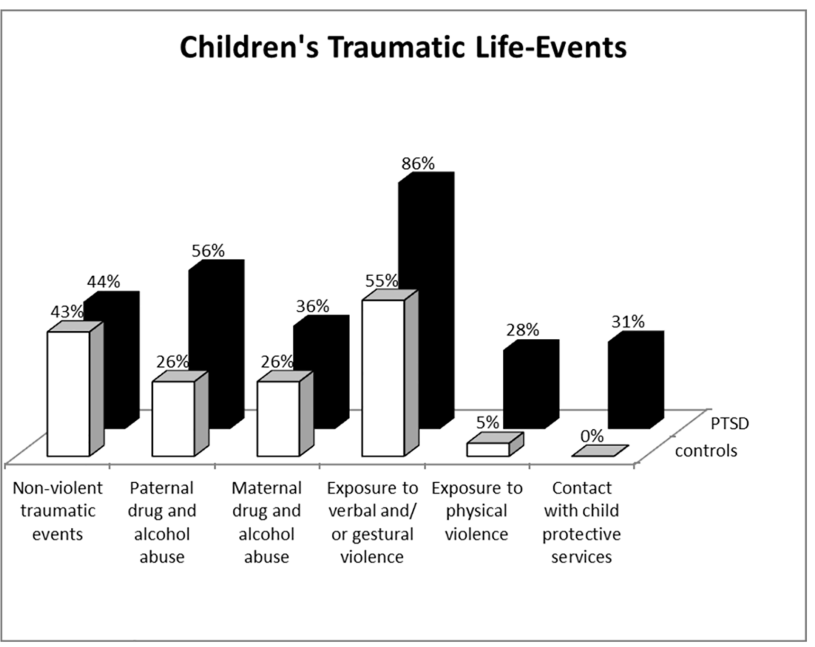
Fig 1. Distribution of children’s exposure to violence by maternal report using the Child Exposure to Violence